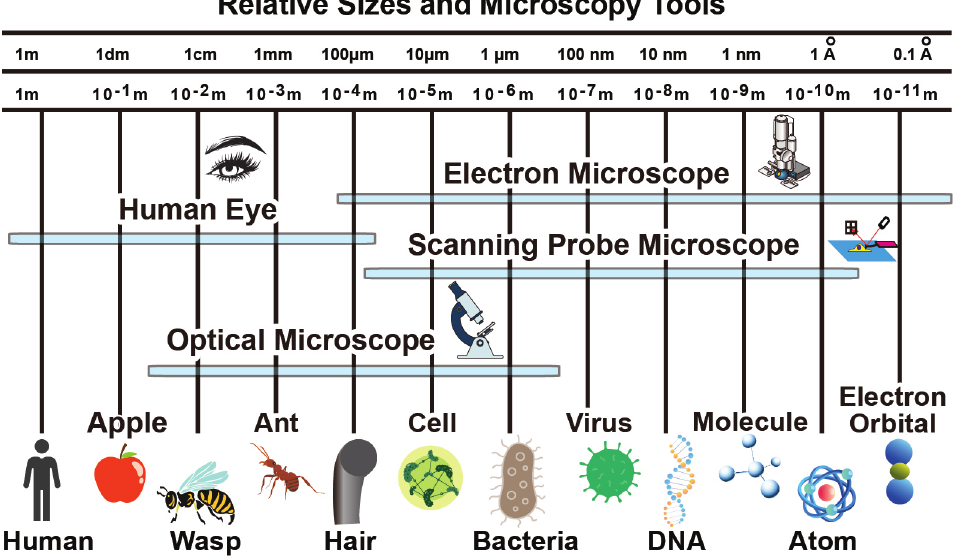
Figure 1. Typical size of biological objects and resolution capabilities of microscopy